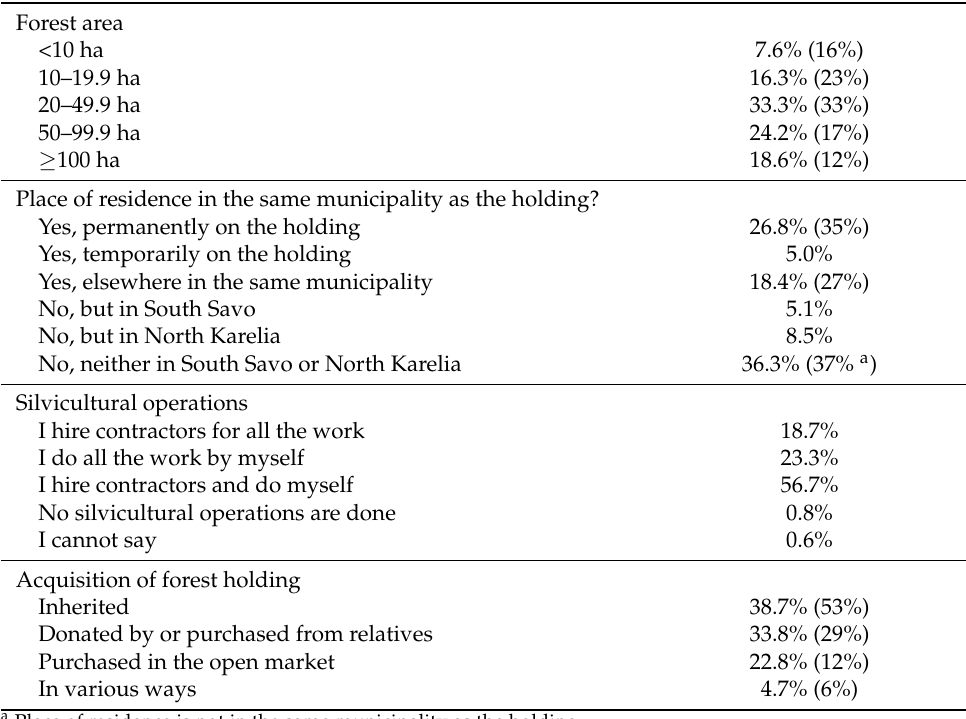
Table 2. Forest owners’ background variables (n = 2355–2398) compared to the national Forest Owner 2020 survey [16] (% of forest owners in